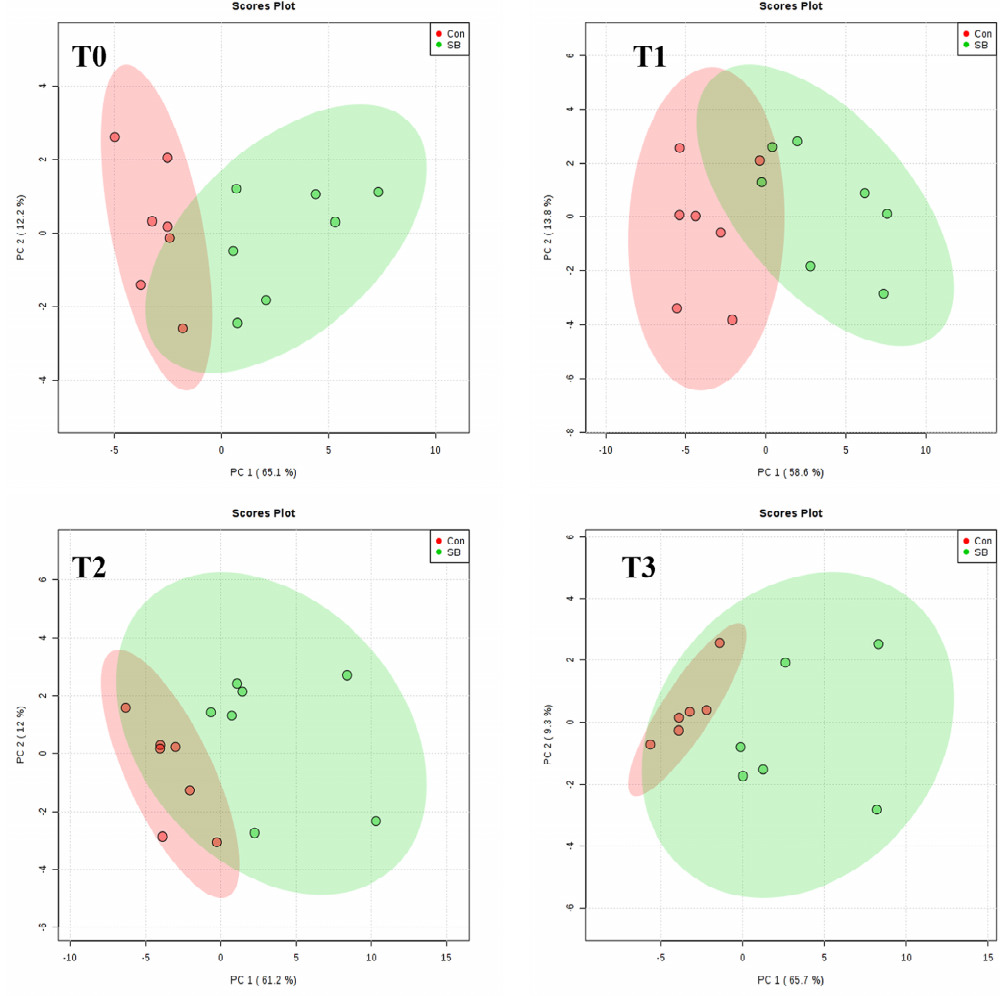
Figure 3. Principal component analysis (PCA) score plot of metabolites of pigs in the control (Con) and sodium butyrate (SB) groups at T0 (0 min, n = 7), T1 (30 min, n = 7), T2 (60 min, n = 7), and T3 (120 min, n = 6) after intravenous